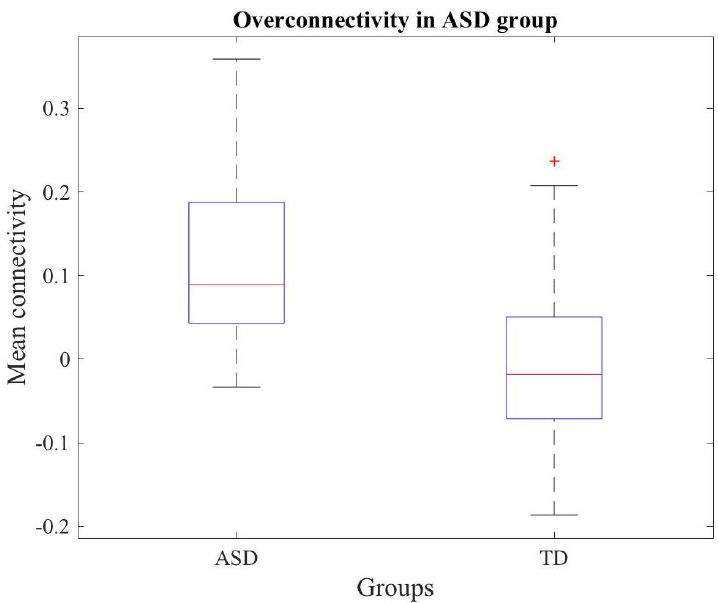
Figure 3. Box and Whiskers diagram representing the mean connectivity in ASD and TD groups for the different connections comprised in the network obtained under the overconnectivity hypothesis.